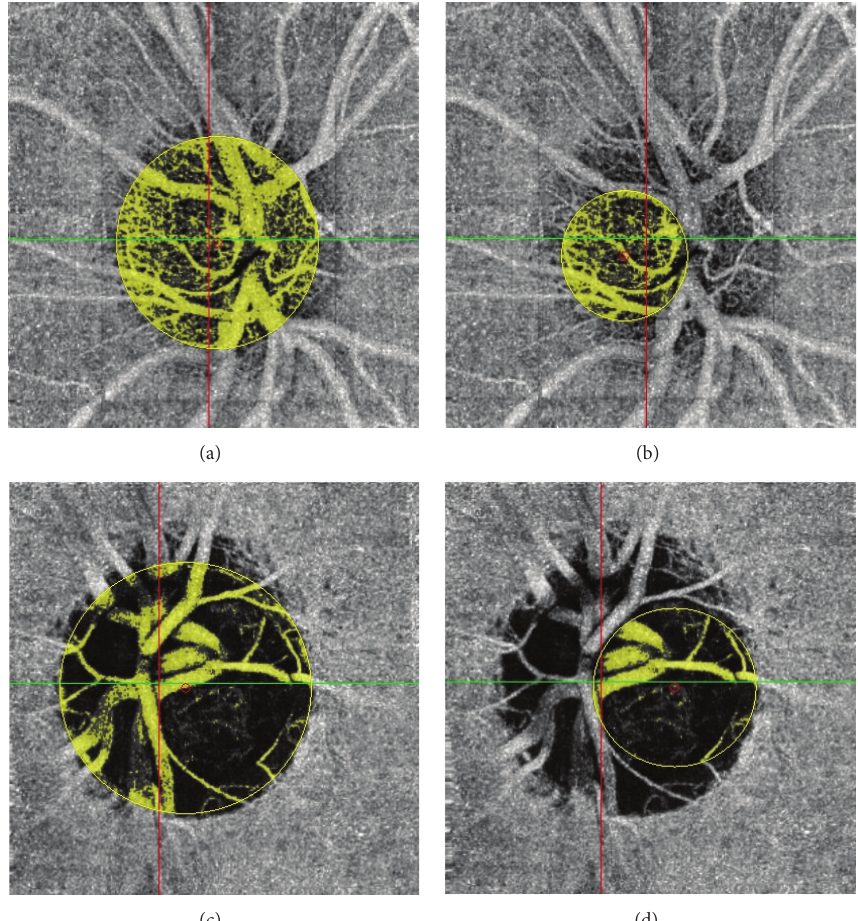
Figure 1: Total (a) and temporal (b) ONH acquisition in a normal patient. Total (c) and temporal (d) ONH acquisition in a glaucoma